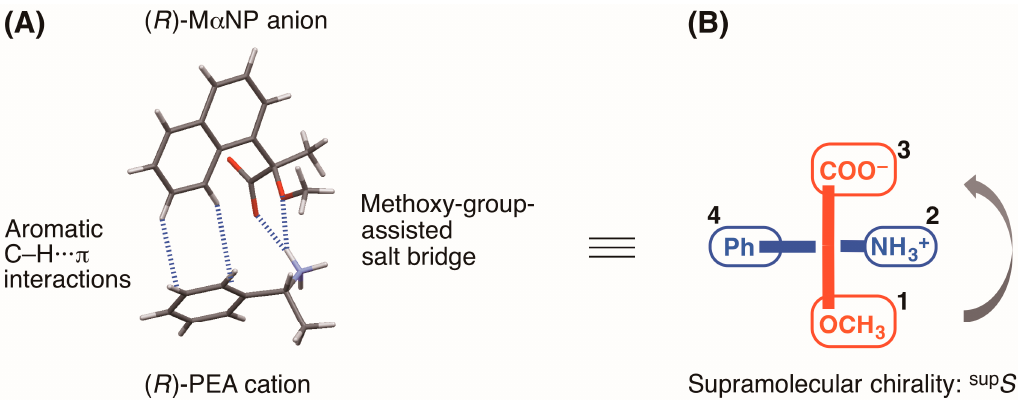
Figure 2. ( A ) Chiral recognition and ( B ) supramolecular chirality in the close ion-pair of the less soluble M α NP salt 4 [6,10]. Assigned numbers indicate priority based on the Cahn–Ingold–Prelog rules. The symbol “ sup S ” represents the left-handed supramolecular chirality.